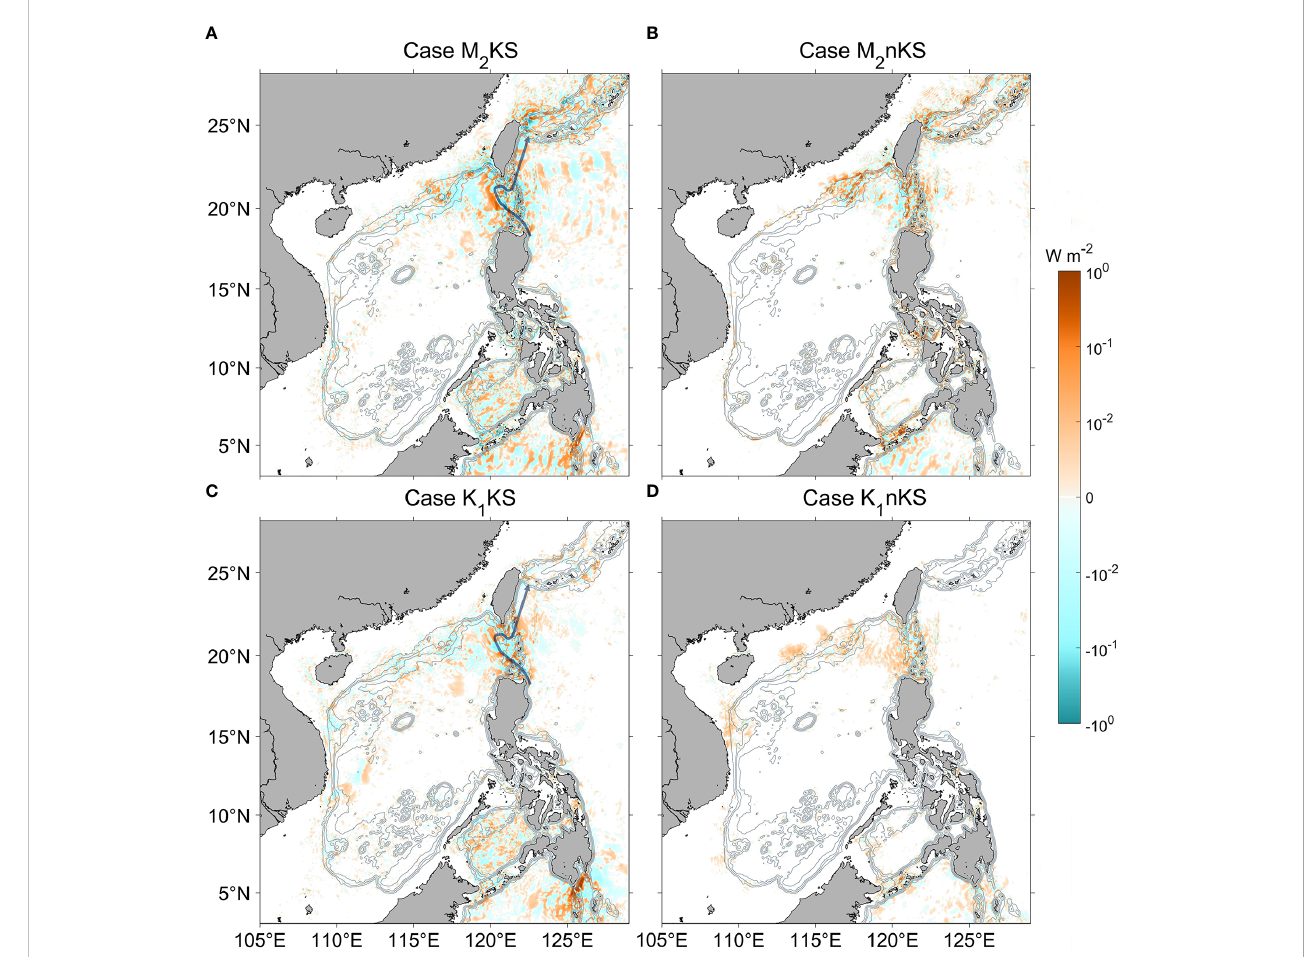
FIGURE 7 Distribution of I m-bc (color, W m -2 ) for four summer cases. (A) M 2 KS. Gray contours indicate isobaths. The blue line shows the Kuroshio path during the simulation period. (B)